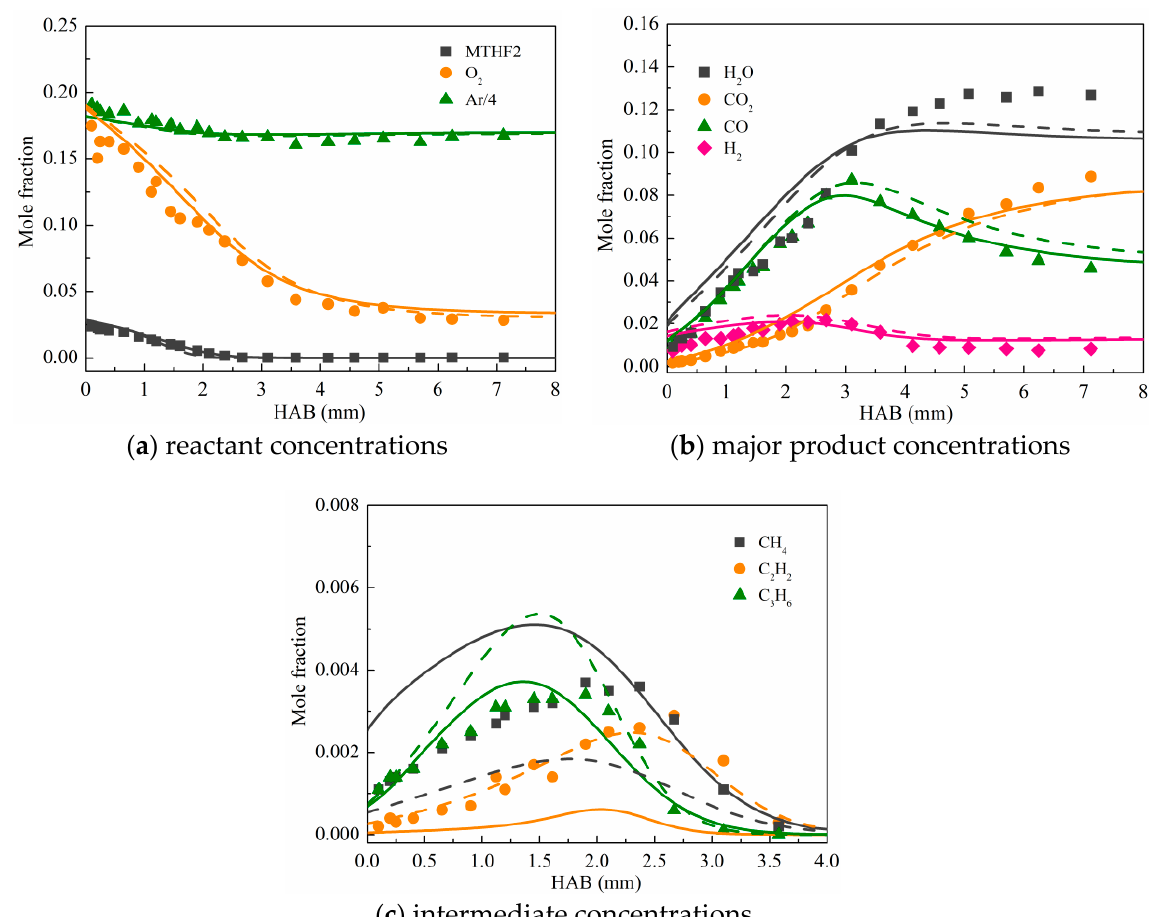
Figure 10. Measured (symbols) [16] and calculated (lines) species concentrations in premixed MTHF2 flames at φ = 0.7. Solid lines: reduced diesel/MTHF2 mechanism; dashed lines: detailed MTHF2 mechanism [17].